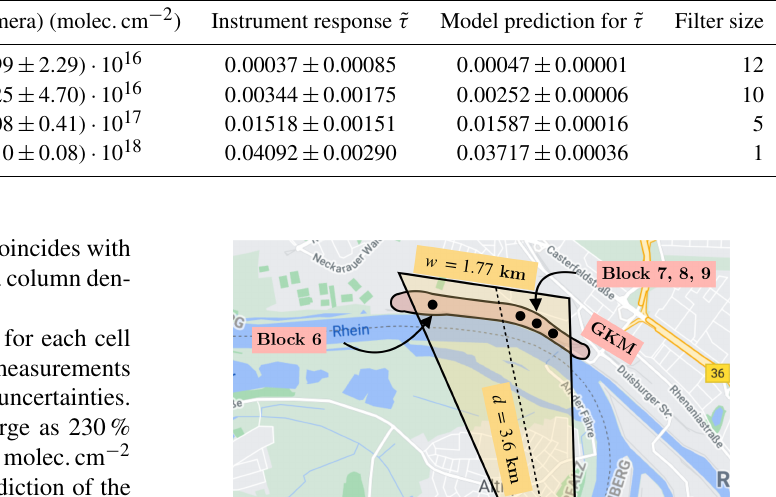
by the DOAS setup and the NO 2 camera. The measurements taken with the NO 2 camera show significant uncertainties.